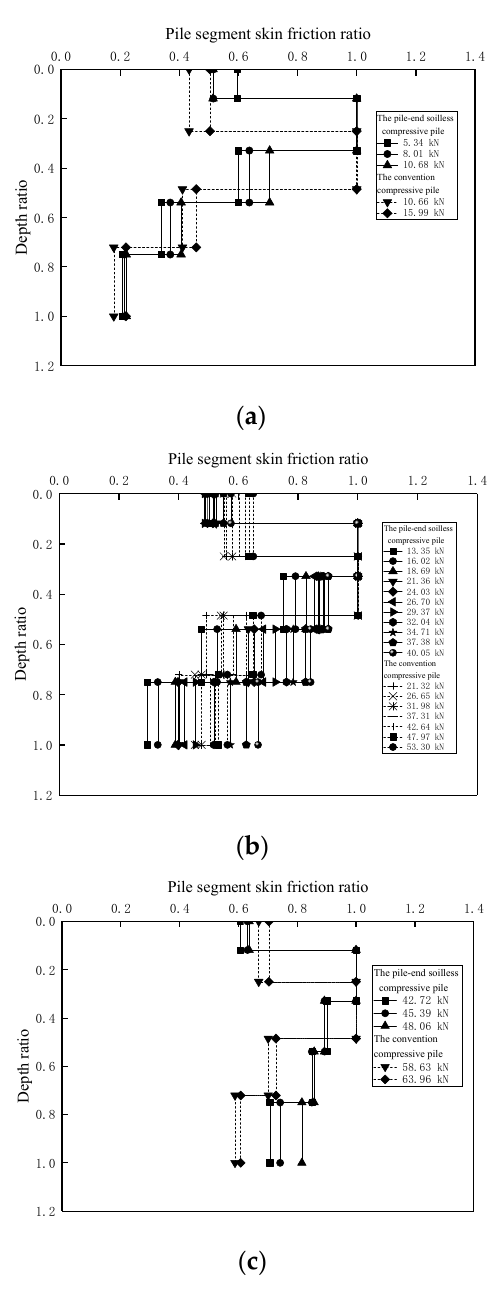
Figure 8. Distribution curve of the pile segment skin friction ratio along depth: ( a ) the linear stage, ( b ) the local shear stage, and ( c ) the failure